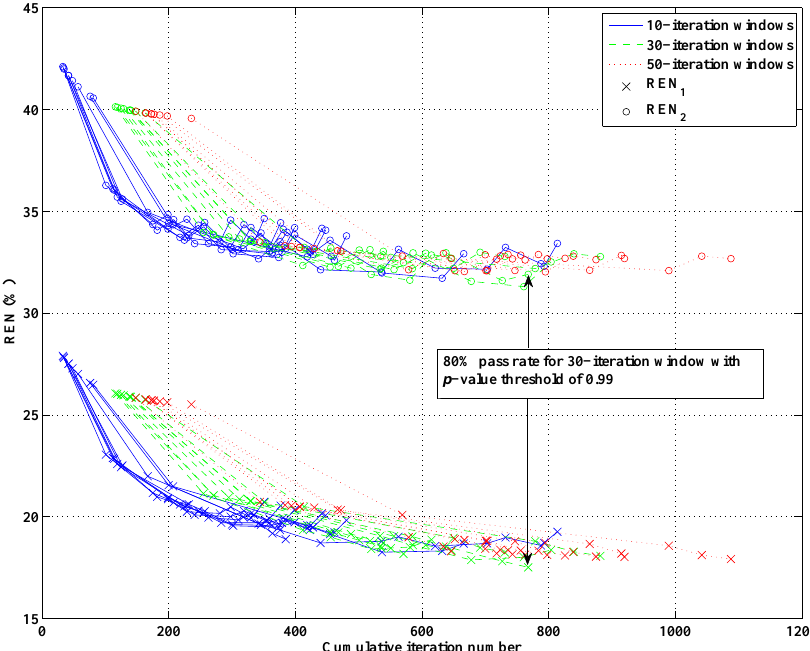
Figure 6. Relative error norms of open-boundary 2D DGM-CSI reconstructions across several choices of stopping criteria parameter values. Each curve in the figure corresponds to a frequency-cycled inversion for a particular choice of the three parameters (Section 3.1), with the window sizes coded by color for convenience. Data points on each curve correspond to REN values for the reconstructed model at each frequency change. Arrows point to the final REN values of simulations that terminated with the lowest relative error norms, indicating the best combination of parameters among those tested for this imaging